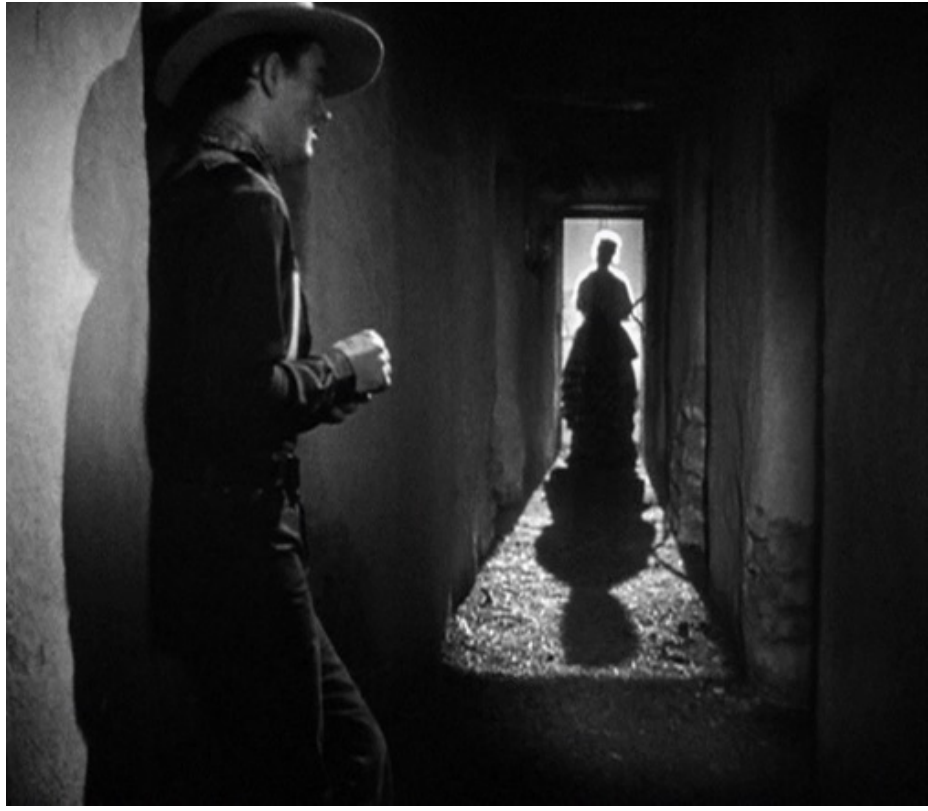
Figure 2: Shot in black and white, and using stock characters, Ford’s film is a classic because it used all the elements of standard low budget Westerns but with high quality shots, scripts, acting and direction. The shot at left, Ringo watching Dallas, is one of the great stills in film